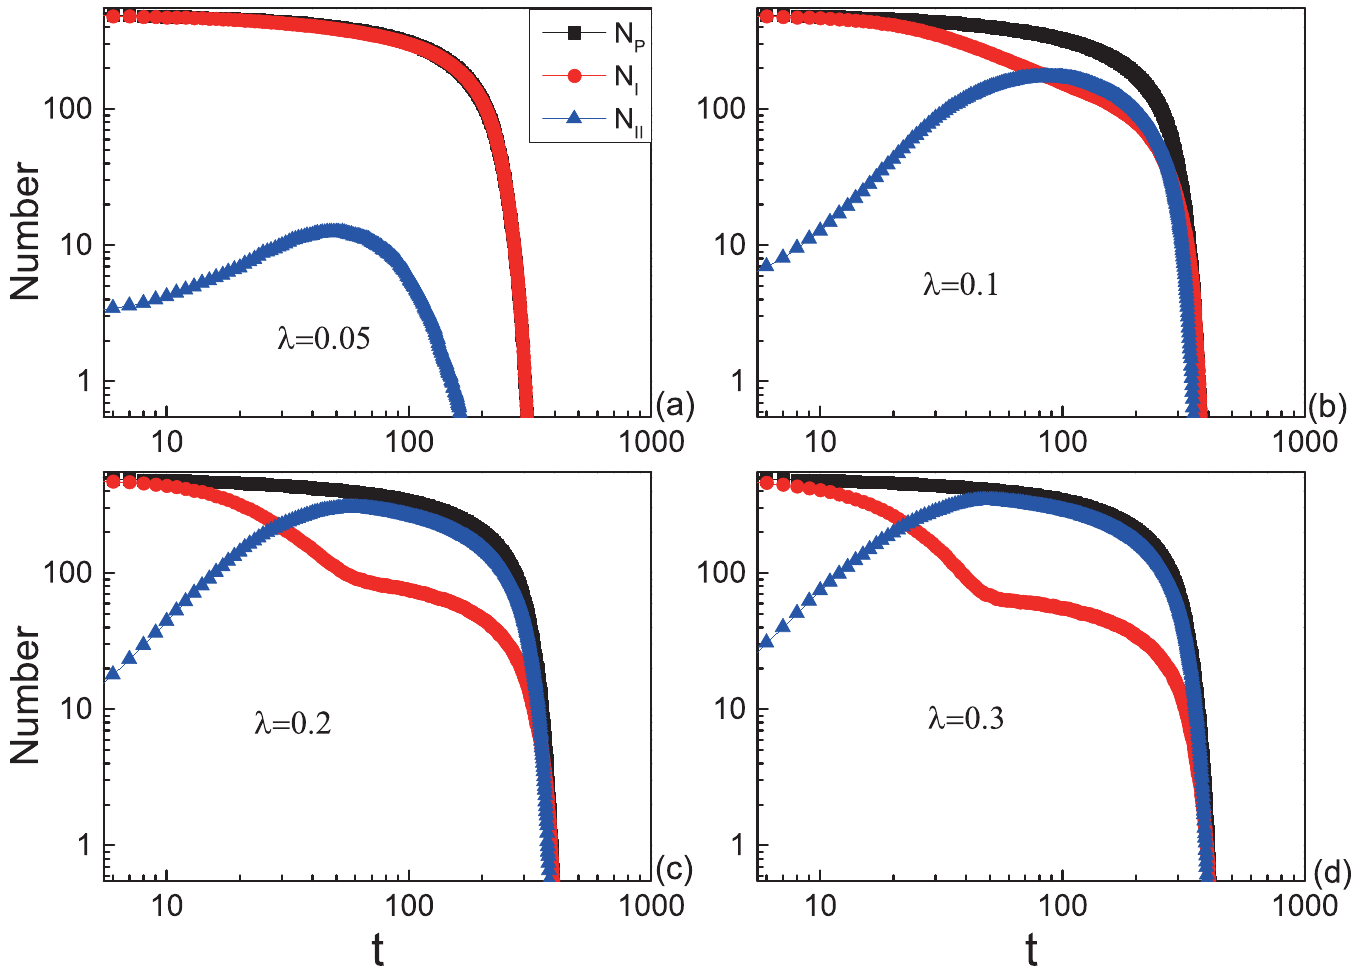
Fig 6. Evolution of the number of pedestrians ( N p ), the number of pedestrians with motion mode I ( N I ) and mode II ( N II ) in the system for different λ . All the data points above are obtained by averaging over 500 different realizations. Initially, N II = 5.